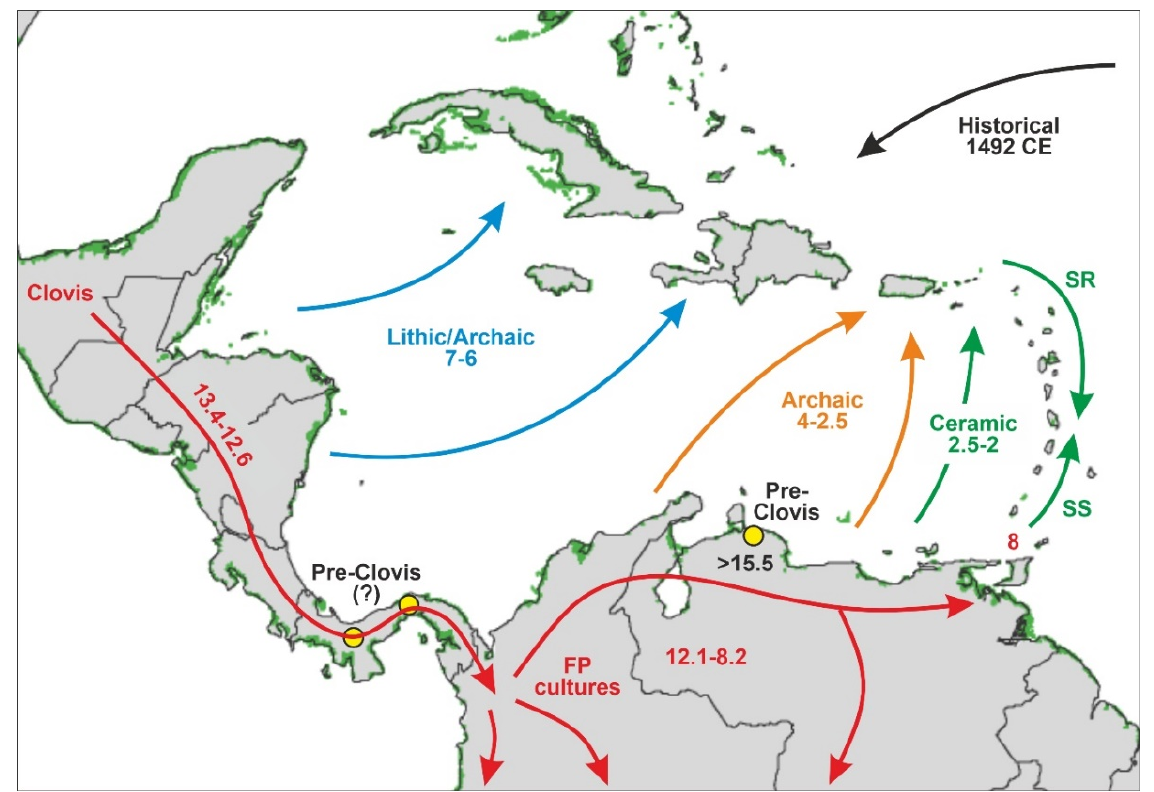
Figure 11. Human migration and settlement patterns across the Caribbean region considered in this study, composed from Refs. [105,109–111,114–119]. Numbers are ages in cal kyr BP. FP cultures, Fishtailed-Point cultures; SR, southern route hypothesis; SS, stepping-stone hypothesis.